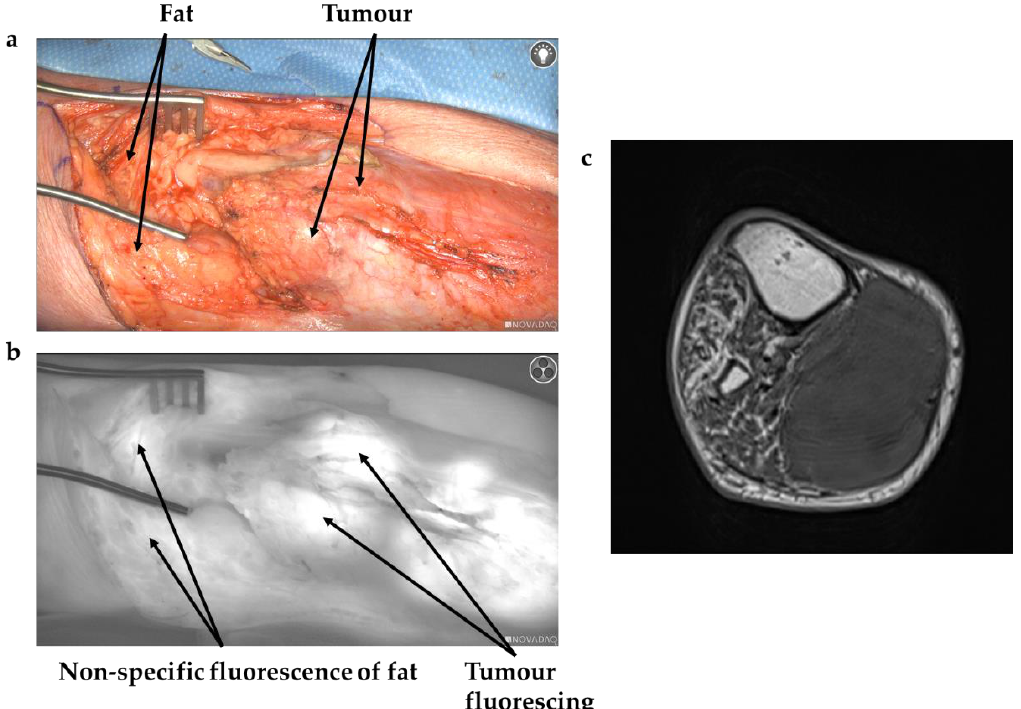
Figure 1. ( a ) White light image of approach to leiomyosarcoma in gastrocnemius ( b ) Demonstrates the same view imaged with NIR camera after ICG given at induction. Arrows demonstrate background fluorescence of normal tissue. ( c ) Axial MRI of tumour.